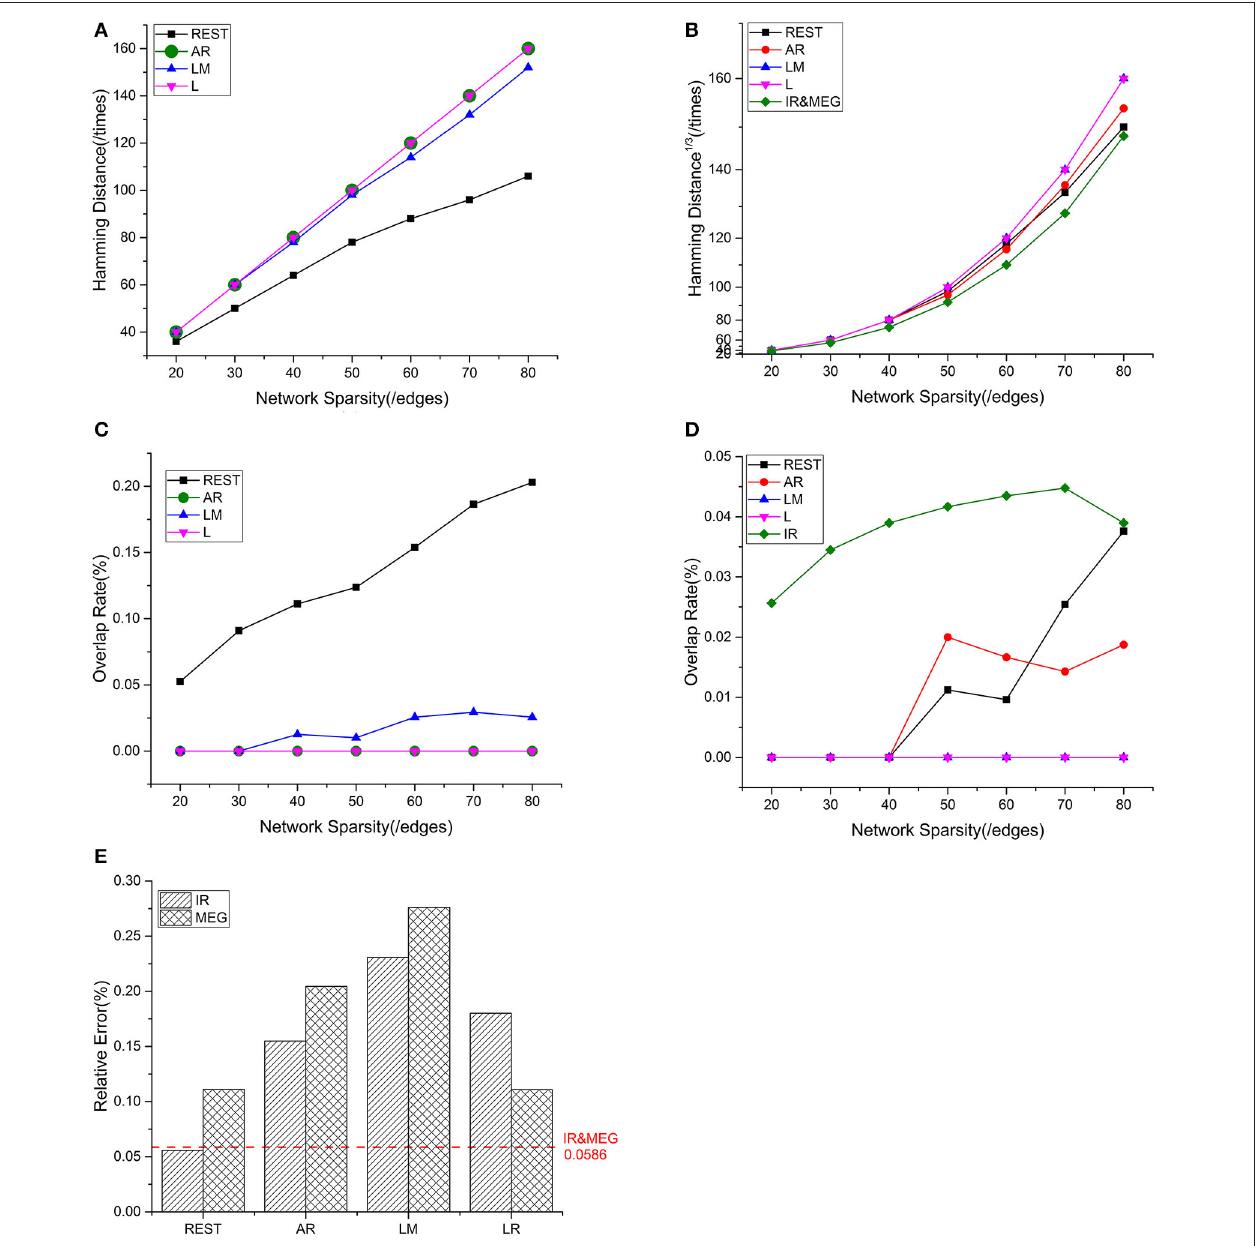
FIGURE 4 | Results of one fixed dipolar pair with different network sparsities. Network sparsity ranges from 20 to 80. (A) HD (Hamming Distance) between each EEG reference and the EEG IR at different network sparsities. (B) HD between each EEG reference and MEG at different network sparsities, including the HD between EEG IR and MEG. (C) OR (Overlapping Rate) between each EEG reference and the EEG IR at different network sparsities. (D) OR between each EEG reference and MEG at different network sparsities, including the HD between EEG IR and MEG. (E) RE (Relative Error) between each EEG reference and two standards (MEG and the EEG IR). The red dash line is used to represent the RE between IR and MEG, which stays the same despite the change in sparsity.